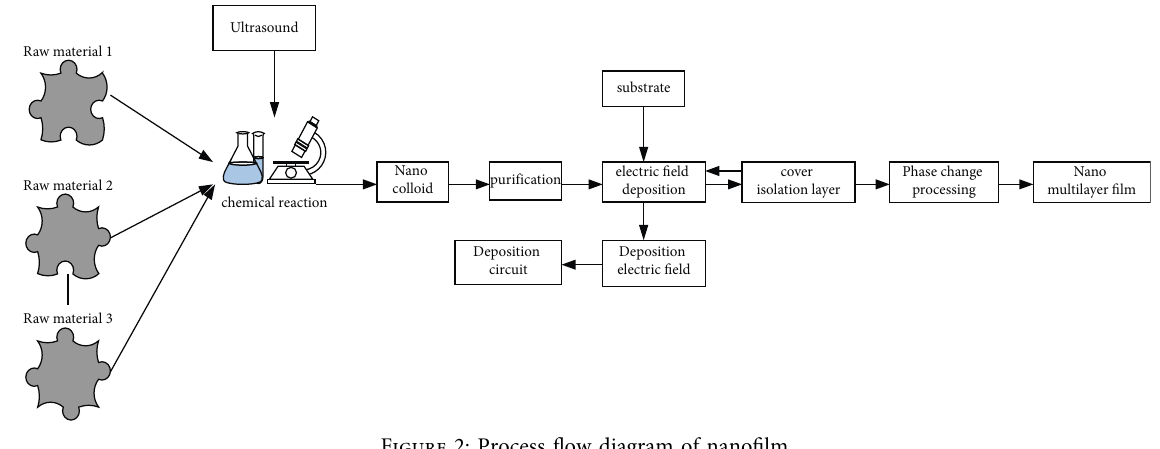
Figure 2: Process flow diagram of nanofilm.